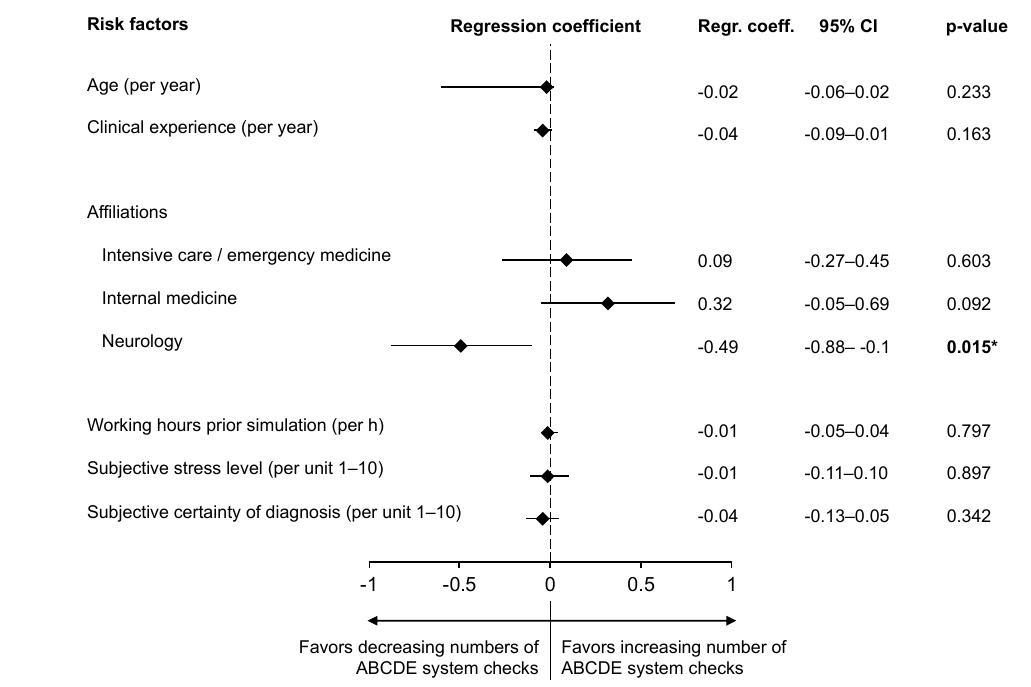
Figure 3. Participants’ characteristics, associated with adherence and non-adherence to the ABCDE approach, during management of a simulated status epilepticus. CI = confidence interval; * Neuro- logic affiliation was the only significant association with increased odds for not checking airways (OR 0.31, 95% CI 0.1–0.94, p = 0.038).